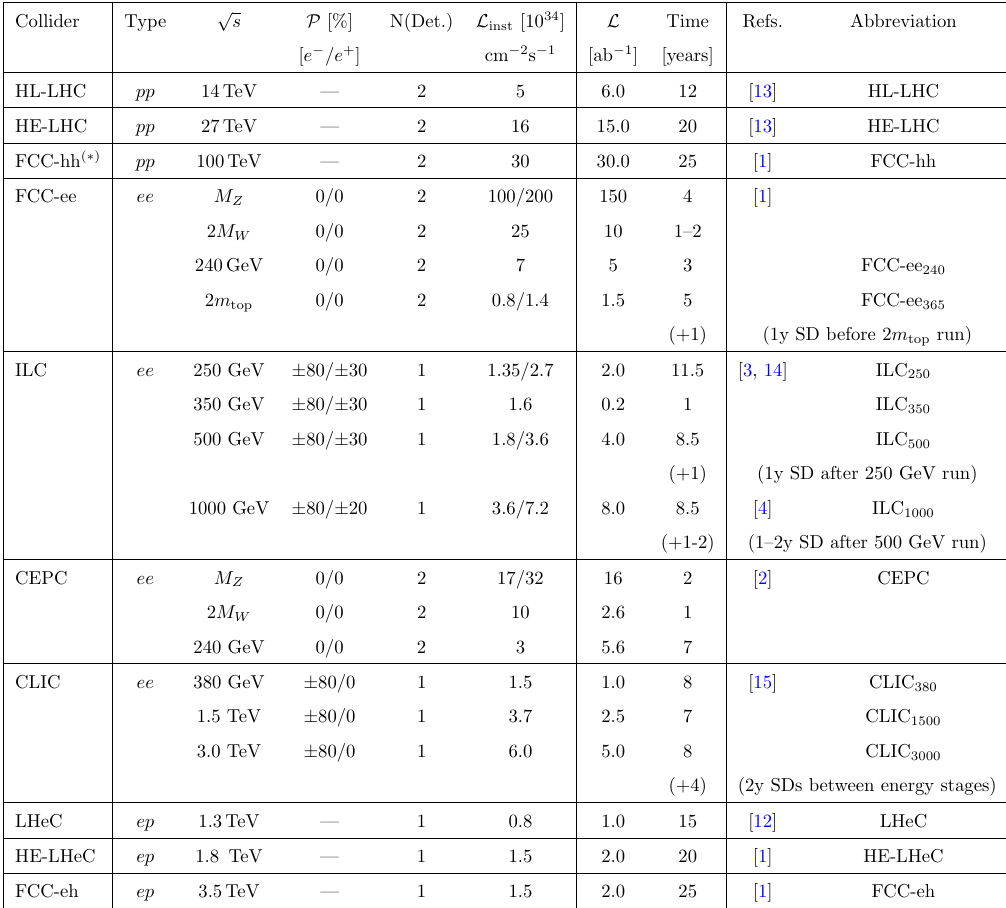
Table 1 . Summary of the future colliders considered in this report. The number of